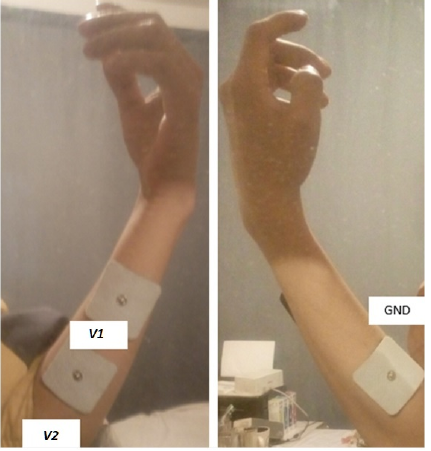
Figure 11. Location of the electrodes on the arm.